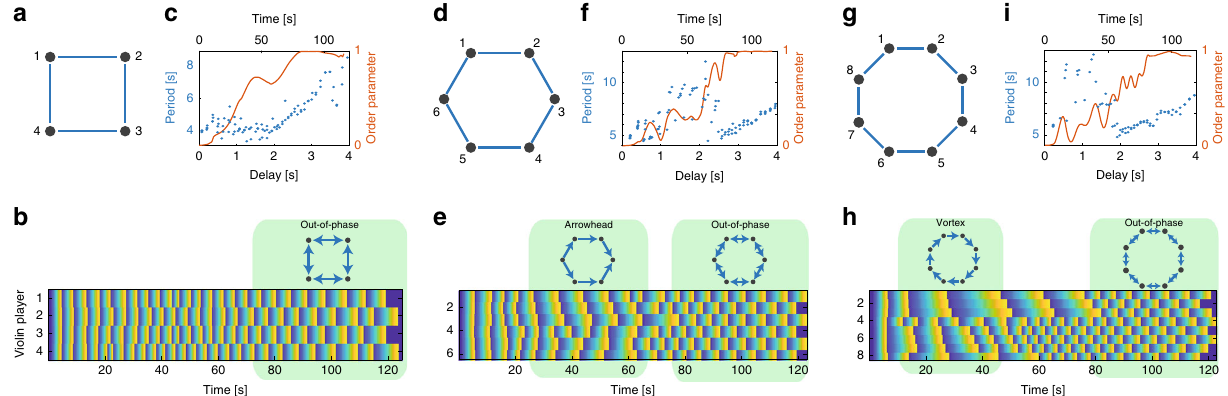
Fig. 4 Four, six, and eight coupled violin players. The con fi gurations of the coupled players are schematically shown in a , d , and g . The phase of each violin player along the musical phrase as a function of time, in one representative measurement, is shown in b , e , and h . The delay between the players is increasing linearly in time. When the delay is low, we observe an in-phase synchronization; when the delay increases, we observe a vortex or an arrowhead state of synchronization; and when the delay is half of the playing period, we observe a stable out-of-phase synchronization. In c , f , and i , we present the playing period and the out-of-phase order parameter as a function of time and the delay. As shown, when the players experience out-of-phase synchronization, indicated by an order parameter of unity, the playing period increases linearly with the delay, remaining twice the delay to preserve the highly stable state of out-of-phase